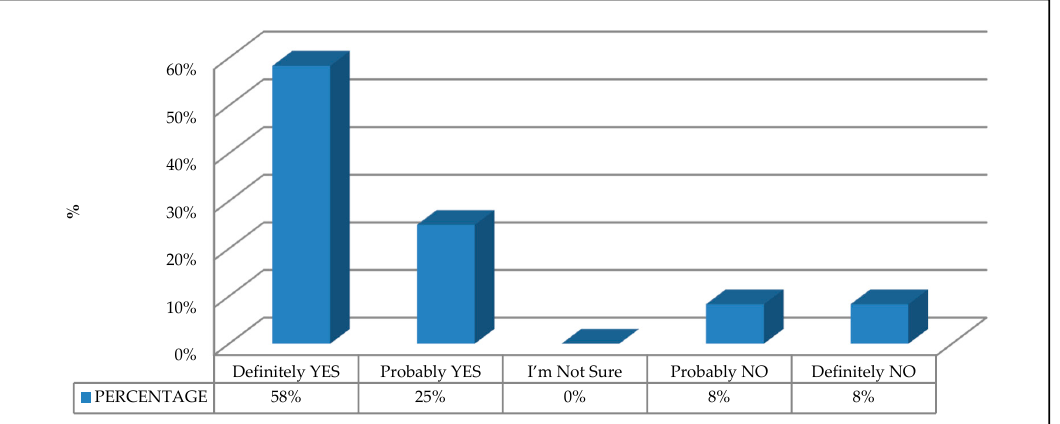
Figure 9. Evaluated need for specific training and qualifications for scaffolding assemblers if enacting an European Union product safety directive for access scaffolding.